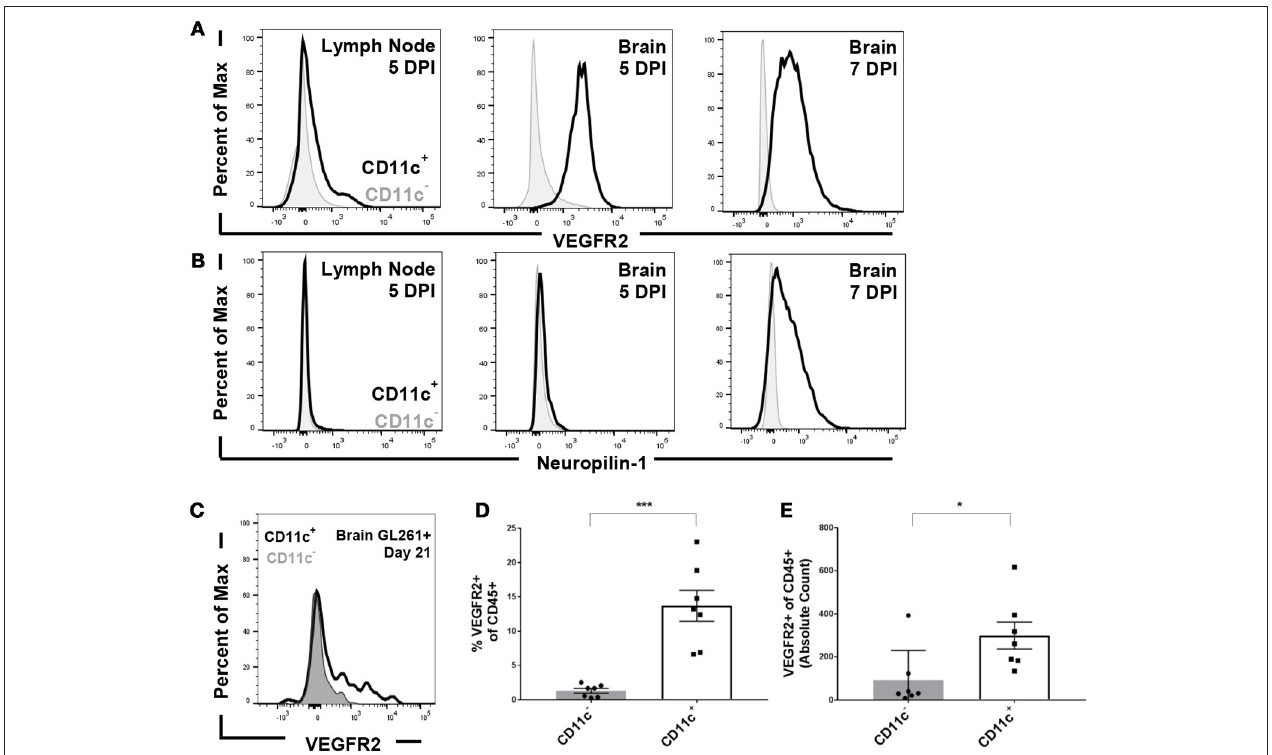
FIGURE 1 | Dendritic cells express VEGFR2 and neuropilin-1 in the brain during picornavirus infection and 21 day established GL261 glioma. Dendritic cells were isolated from the cervical lymph node and brain five and seven DPI. Dendritic cells were gated as CD45 hi and CD11c + . (A) Dendritic cells in the lymph node and brain express VEGFR2, with a majority of dendritic cells expressing VEGFR2 seven DPI in the brain. (B) Brain-infiltrating dendritic cells express neuropilin-1, a co-receptor for VEGF, in the brain seven DPI with TMEV. (C) Representative flow plot showing expression of VEGFR2 in both CD11c + and CD11c − cells isolated from the brain of unvaccinated animal bearing GL261 glioma. (D,E) In untreated mice with 21 day established GL261 gliomas, we observed CD11c + dendritic cells in the brain express higher levels of VEGFR2 ( N = 7). Data presented as mean with error bars representing standard error of the mean (SEM). * p ≤ 0.05 and *** p ≤ 0.001 by Mann–Whitney U